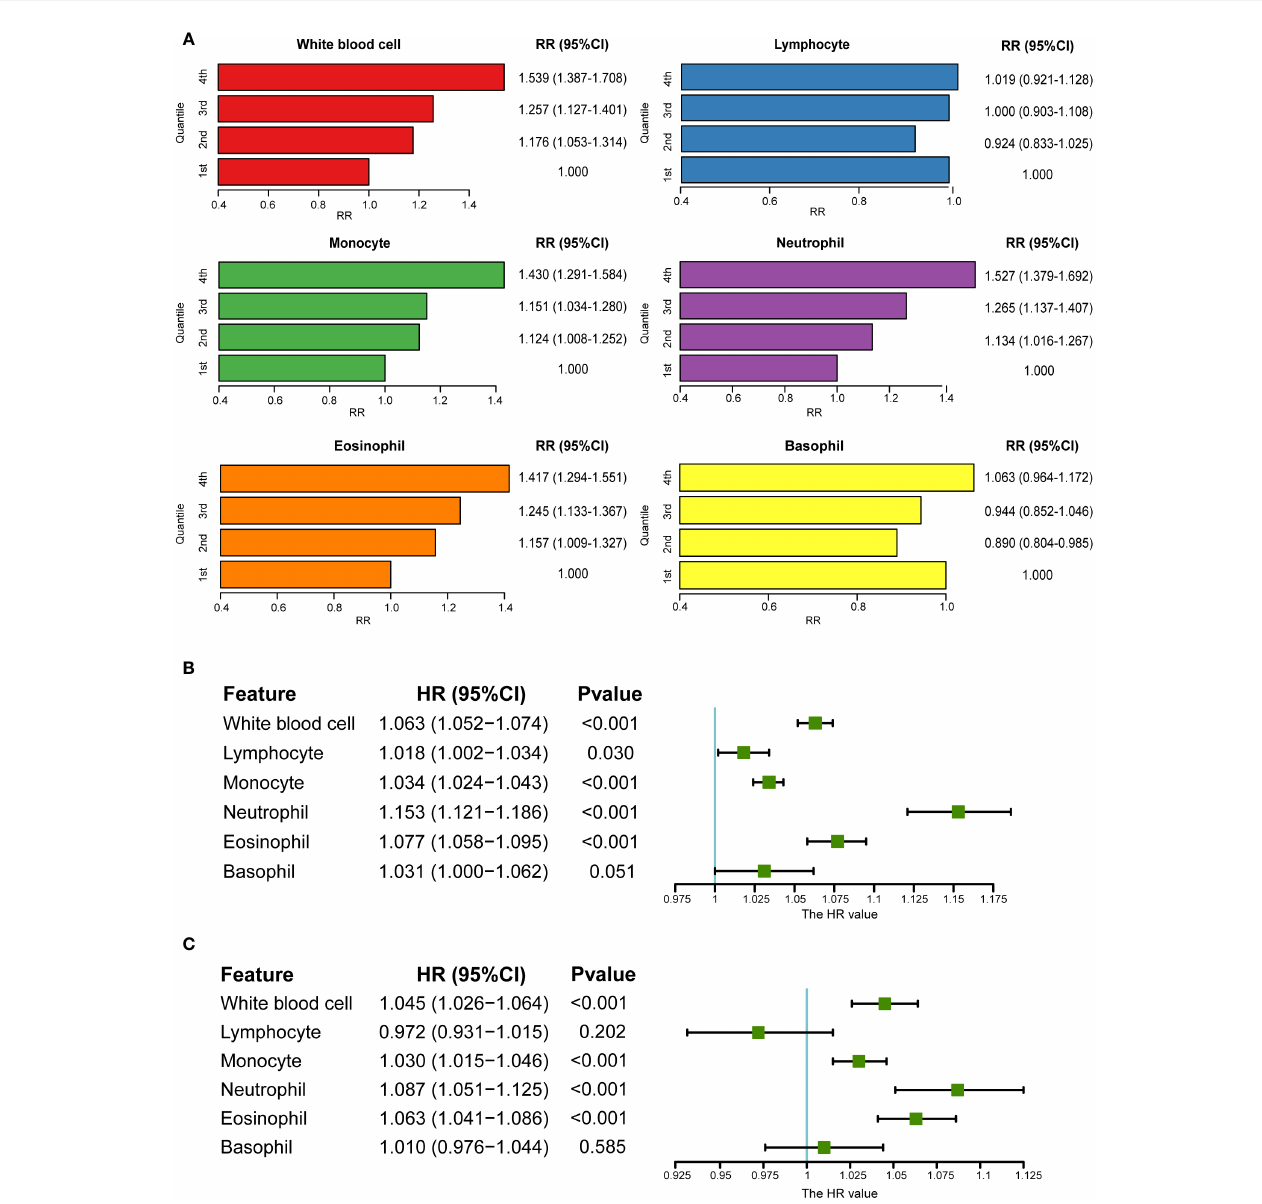
FIGURE 2 Association between circulating white blood cells and psoriasis in UKB. (A) RRs of psoriasis from categories of white blood cells (the fi rst category was viewed as a reference). (B) Association between white blood cells and psoriasis in univariate Cox regression. (C) Association between white blood cells and psoriasis after adjusting for covariates in multivariate Cox regression (sex, age, BMI, smoking status, and alcohol drinking